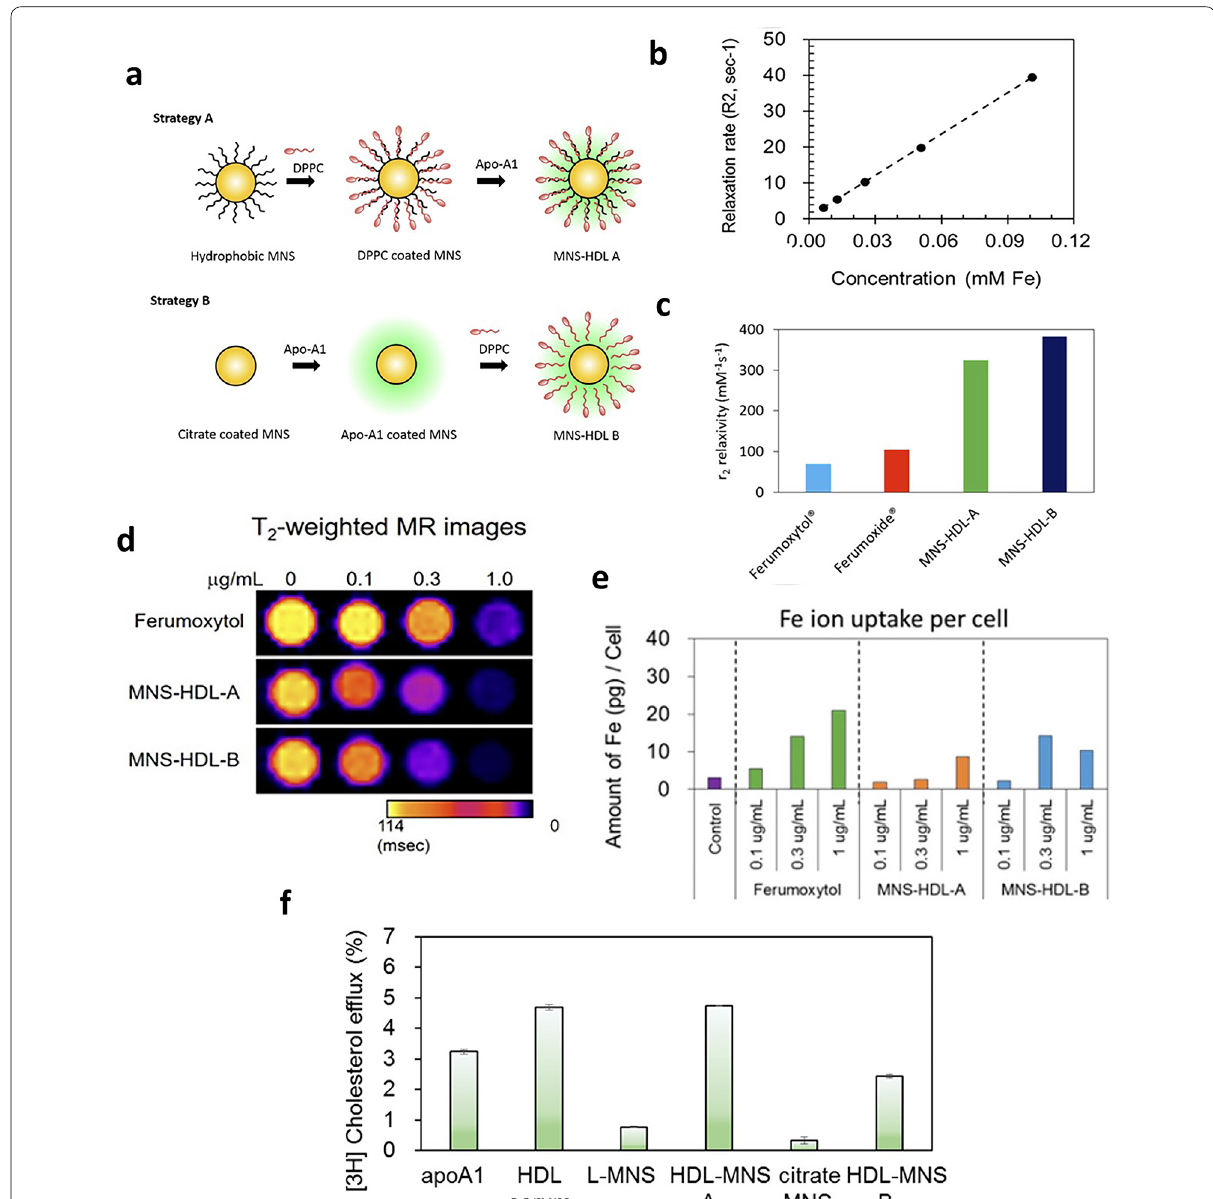
Fig. 5 a Approach 1 to synthesize HDL‑MNS A particles where oleic acid coated hydrophobic MNS were first coated with a neutral lipid 1,2‑dipalm itoyl‑sn‑glycero‑3‑phosphocholine (DPPC) and later coated with apolipoprotein A1 (apoA‑1). In approach 2, hydrophilic MNS were first coated with apoA1 and then coated with DPPC, resulting in HDL‑MNS B particles. b r 2 relaxivity plot of HDL‑MNS B particles measured at 1.4 T. c Comparison of r 2 values of HDL‑MNS A and B with commercially available contrast agents (ferumoxytol, and ferumoxide). d T2‑weighted MR images shows darker signal (decrease in T2 relaxation time) with the increase of Fe concentration. e Amount of Fe ion taken up per cell was measured via ICP‑MS of cell pellets fed with difference concentrations of Ferumoxytol and HDL‑MNS f cholesterol efflux from J774 macrophage cell lines by HDL‑MNS. Reproduce with permission [64]. Copyright 2017, American Chemical